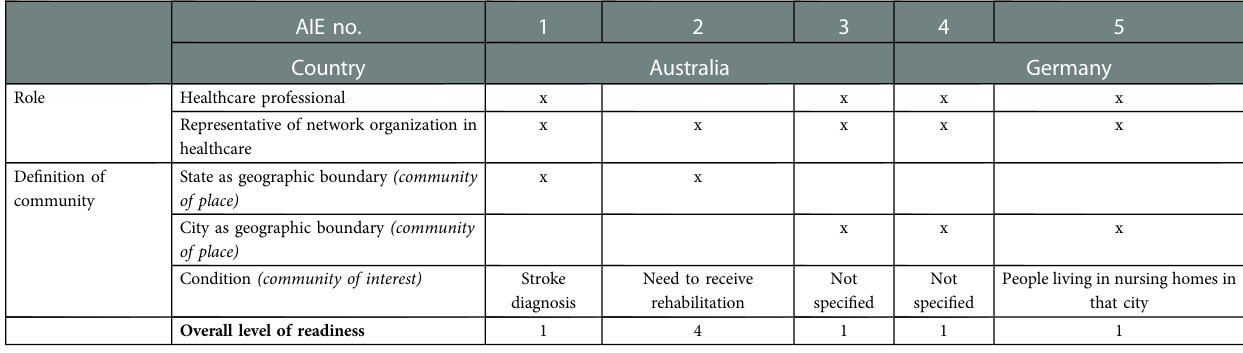
TABLE 4 Expert and community characteristics during the second round of interviews with application-interview experts (AIEs). AIE